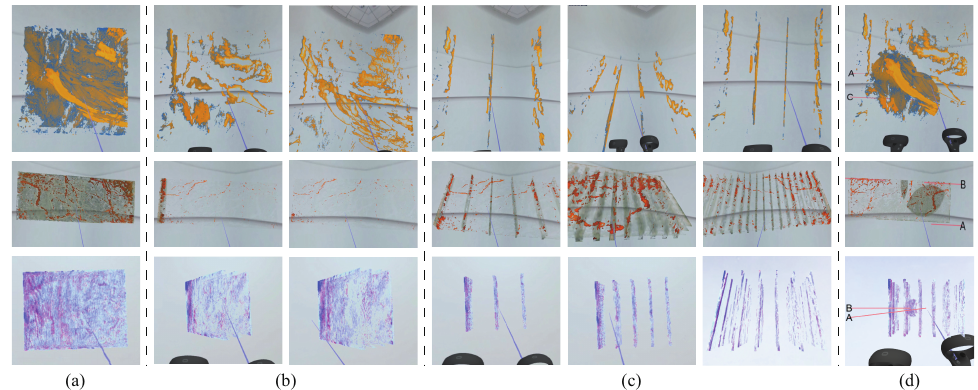
Figure 6. Three datasets were used to display different geological models. ( a ) the whole visualization of stratigraphic data; ( b ) the armchair display mode by Touch Handle; ( c ) the palisade display mode by Touch Handle; ( d ) a combination of the cross-shaped display mode and the extracted stratigraphic structures. As shown in the pictures above, the thickness of the slices and the interval between slices in the palisade or armchair display mode can be adjusted by touching the handle. Table 2. Three stratigraphic datasets are used to test the processing performance of our tools in the HMD. The time of the data preprocessing and the size of display frame rate in HMD shows the performance of our tool for different stratigraphic